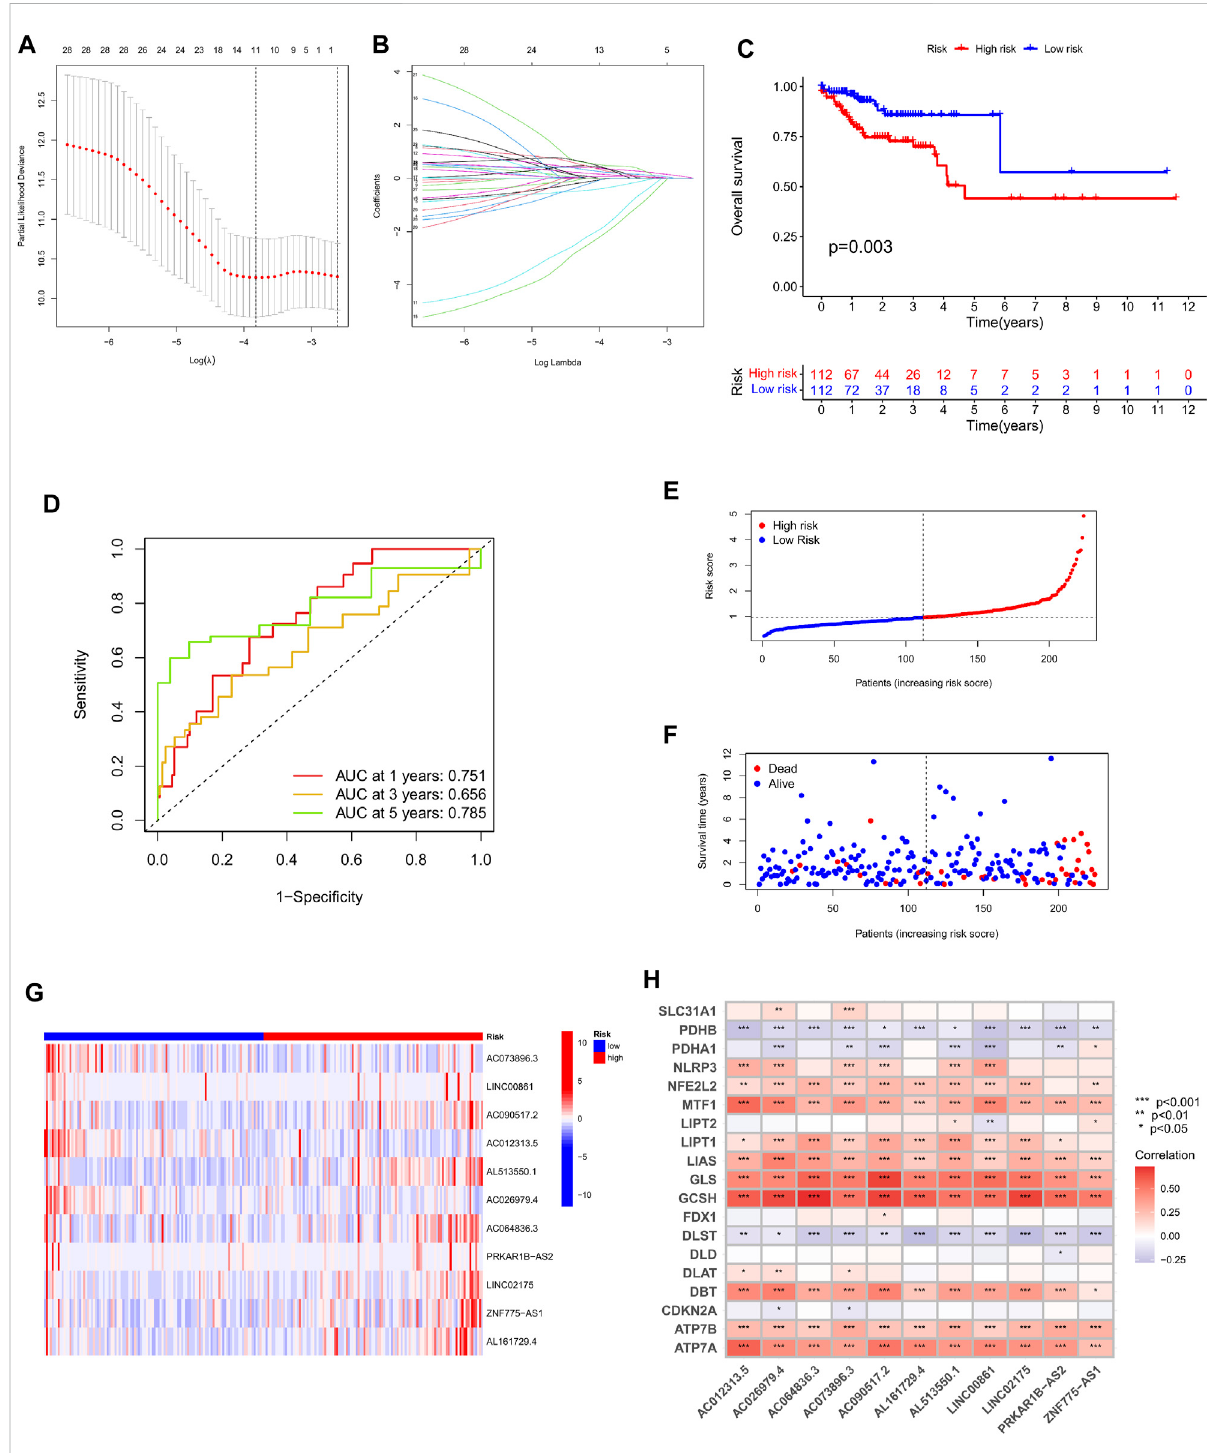
FIGURE 4 Construction and evaluation of OS-related cuproptosis-related lncRNA risk scoring models in the training cohort. (A) LASSO coef fi cient curves of 11prognosis-relatedlncRNAs. (B) Ten-foldcross-validationoftuningparameterselectionintheLASSOmodel. (C) Kaplan-Meiercurvesofsurvivaloutcomes for patients in the high and low risk groups. (D) 1-year, 3-year, and 5-year ROC curves and AUC values of the risk scoring model. (E) Risk score distribution. Bluedotsrepresentriskscoresforlow-riskpatients;reddotsrepresentriskscoresforhigh-riskpatients. (F) Relationshipbetweensurvivalstatusandrisk score. The horizontal axis represents the number of patients, and the vertical axis represents the risk score. Red dots represent dead patients and blue dots represent surviving patients. (G) Heatmap showing the expression pro fi les of 11 characteristic lncRNAs. (H) Heatmap of the association of 11 characteristic lncRNAs with cuproptosis-related